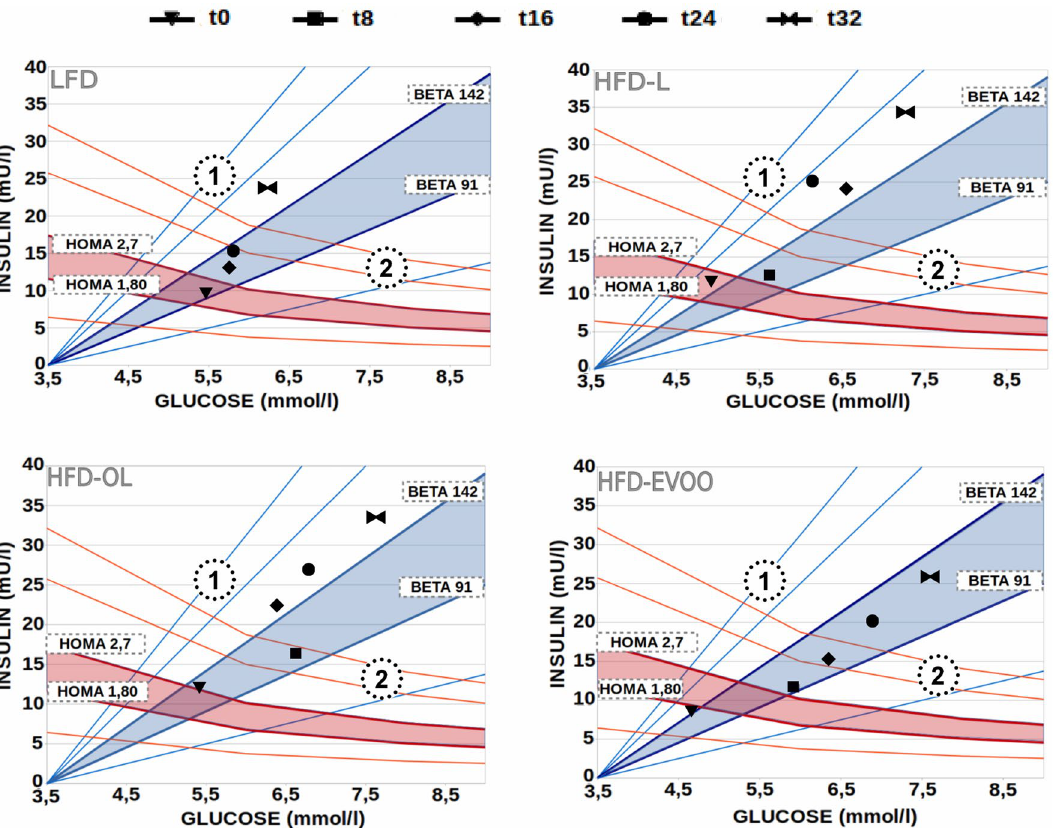
Figure 3. Fasting insulinemia vs glycemia with iso-HOMA-IR and iso-HOMA-%B curves at various timepoints (t) of the study (0, 8, 16, 24, and 32). Blue shadow zones represent the normality range for HOMA-%B (BETA 142 and BETA 91). Red shadow zones represent the normality range for HOMA-IR (HOMA 2.7 and HOMA 1.80). The normality ranges were established using fasting insulinemia and glycemia values at week 0 (t0). The average value and the upper value of the confidence interval for the HOMA-IR index were used, as well as the average value and the lower value of the confidence interval for the HOMA-%B. Area 1 reflects increased HOMA-IR and HOMA-%B. Area 2 reflects increased HOMA-IR and decreased HOMA-%B. The fasting insulinemia and glycemia values represent the means of 10 mice for each nutritional inflammatory cell aggregates stained with macrophage antibody-2 (MOMA-2), was significantly increased with both EVOOs relative to LFD ( p < 0.05), and this effect was even more pronounced in HFD-OL (significantly higher than HFD-EVOO; Fig. 4D). Moreover, at the end of the study, the NAFLD Activity (NAS) score in the LFD group was significantly lower (* p < 0.05; 2.2 ± 0.3; n = 5) than HFD groups (Fig. 4E). No significant differ- ences were observed between HFD groups (4.0 ± 0.0 in the EVOO and OL groups, and 4.6 ± 0.70 in HFD-L group; n= 5) (Fig. 4E). No fibrosis was observed in the LFD group, and the HFD groups showed a comparable fibrosis development (Fig. 4E). Hematoxylin–eosin staining of livers showed an increase in fat deposition in all HFDs treated groups com- pared to LFD (Fig. 5A). Moreover, both olive oil treated groups showed a significant (* p < 0.05) increase in the percentage of the Sirius Red positive area compared to LFD, indicating an increase in collagen deposition (Fig. 5B,D). In line with this, in liver homogenates of both EVOOs, higher amounts of biochemically-determined total collagen were found (* p < 0.05) (Fig. 5E). Figure 5C,F show that livers of both olive oil groups contained less ( *p < 0.05) GATA binding protein 4 (GATA4) positive hepatic stellate cells (HSC), indicating a profibrotic state. Molecular signatures of NASH are induced by in both EVOOs containing diets. To explore the possible relationship between the above-mentioned changes in biochemical parameters and histopathological features with modifications in liver gene expression, we next analyzed the transcriptome in livers collected at the end of study using microarrays gene expression. We compared expression profiles of LFD, HFD-L, HFD- EVOO and HFD-OL as follows: First, hierarchical clustering was used to display the differentially expressed genes (rows) and different type of diets (columns) using half-square Euclidean distance as a similarity measure. Based on the hierarchical clustering of gene expression data, we identified distinct clusters with a distinct gene expression profile (Fig. 6A). Subsequent cluster analysis showed that HFDs differed from LFD (Fig. 6B). Mice consuming HFD-OL showed the highest amount of liver transcript changes (979) compared to LFD. Also, HFD- EVOO showed a large (734) amount of differentially expressed genes (DEG). In contrast, HFD-L mice showed the lowest amount of DEG (576) relative to LFD. Some DEG were common among the different groups, but only